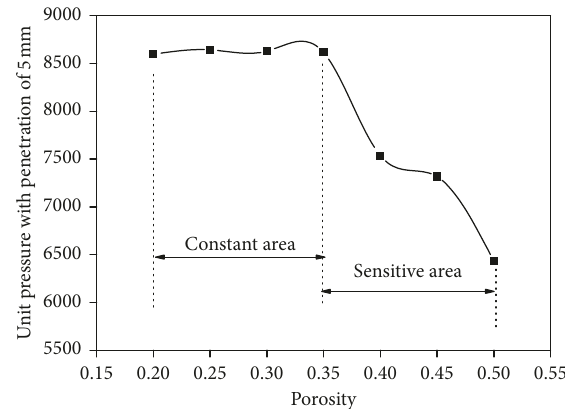
Figure 4: Variation in